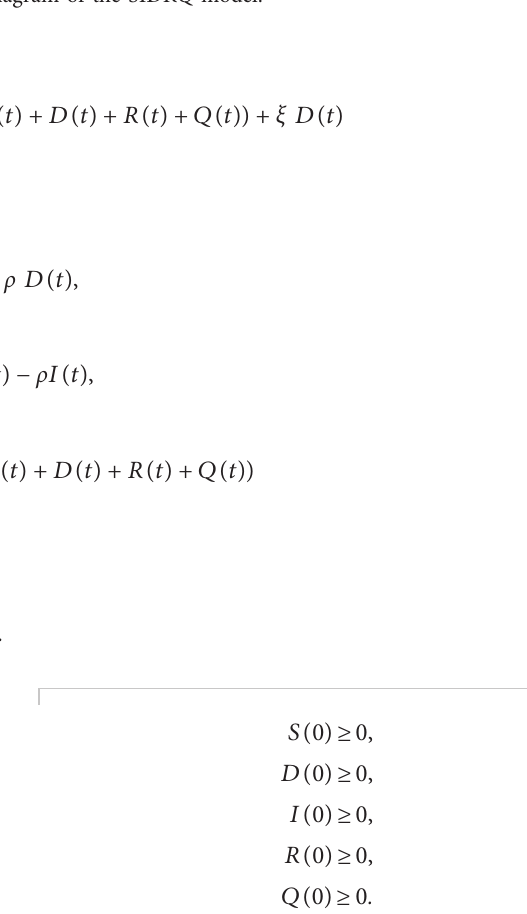
Figure 1: The transfer diagram of the SIDRQ